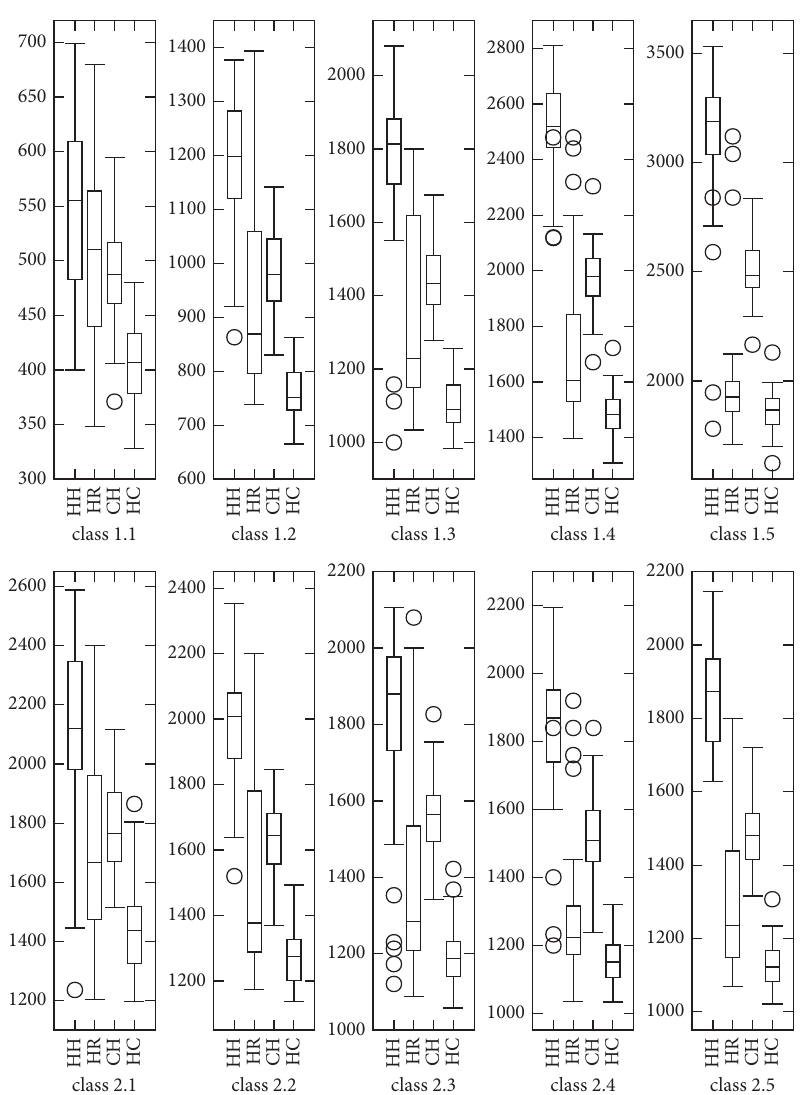
Figure 7: Boxplots of lengths of schedules (minimum, lower quartile, median, upper quartile, maximum, and outliers) returned by the LS algorithms for the benchmark given in [9] with cov �